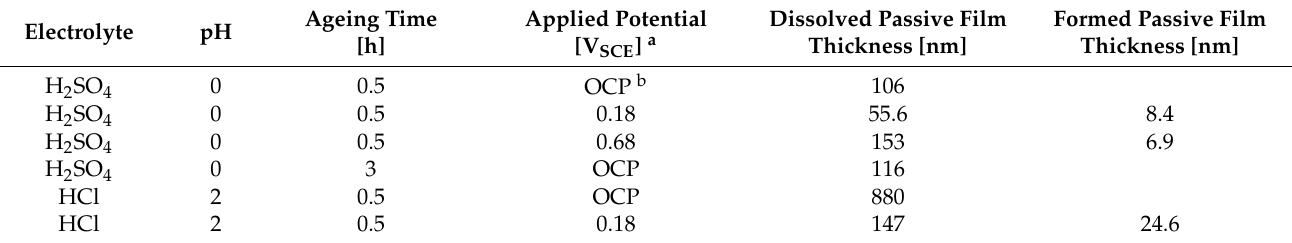
Table 3. Estimated equivalent passive film thickness